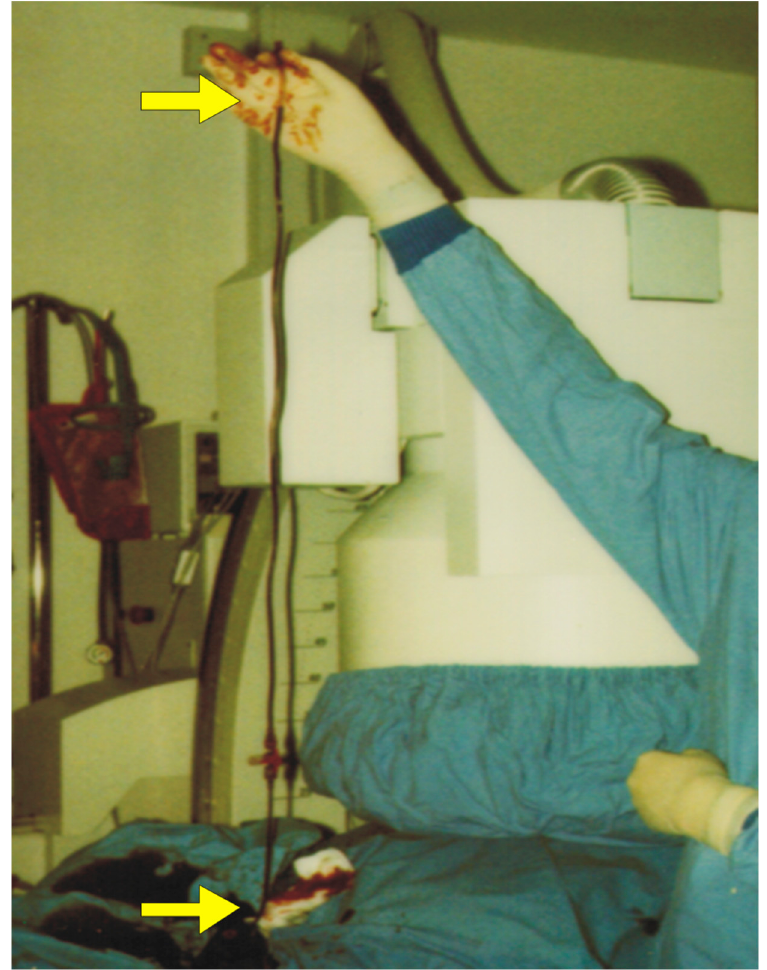
Figure 6. Example of a very high portal pressure in a patient with fulminant BCS. The height of the water column (between the yellow arrows) is 82 cm, corresponding to 63 mmHg. The value was con fi rmed by electronic measurement.